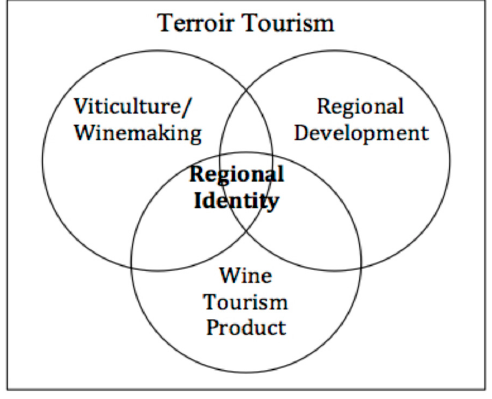
Figure 3. A conceptual framework of terroir tourism (adapted from [33], with permission from Holland et al., 2014). Holland et al.,